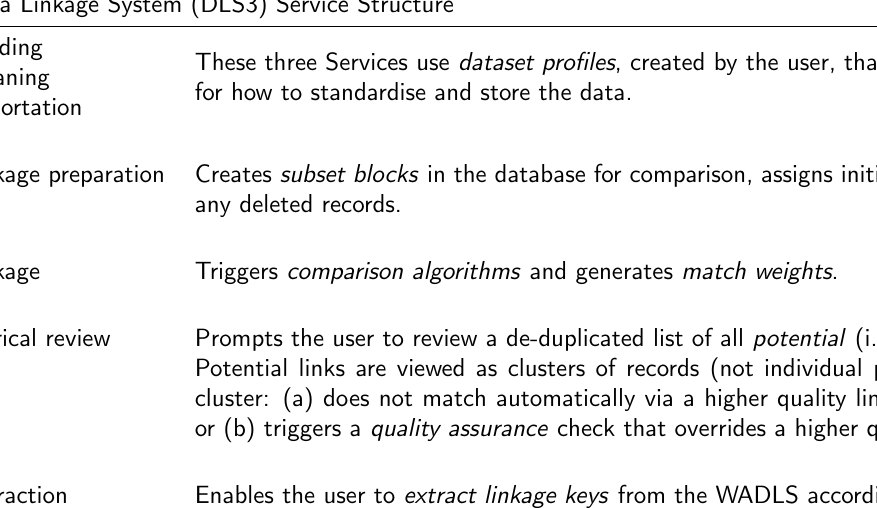
Table 3: Structure of